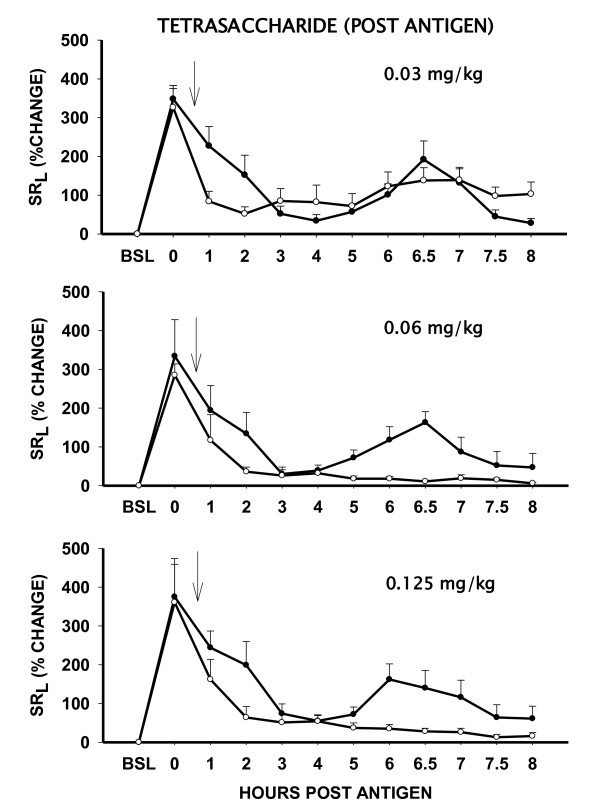
Dose response effect of inhaled heparin tetrasaccharide, administered "AFTER" the antigen challenge, on antigen-induced LAR. Data are shown as % change in specific lung resistance (SRL) ± SE without (solid circle) and after treatment (open circle) with various doses of tetrasaccharide (n = 5). Tetrasaccharide was administered immediately after the post-antigen measurement of SRL (Arrow). BSL = Baseline